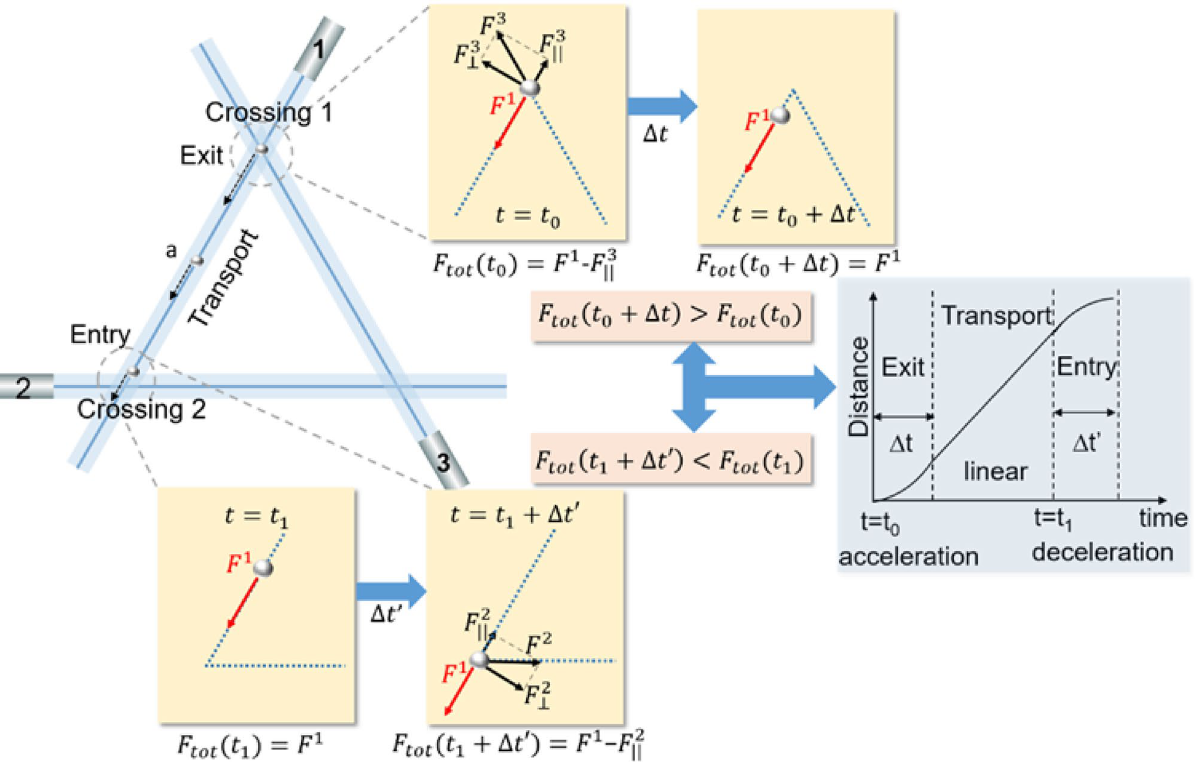
Figure 8. A qualitative explanation of three distinctive motions along a side of the optical triangle, ‘a’. The polystyrene bead moves from ‘Crossing 1’ to ‘Crossing 2,’ showing three segments I-Exit, II-Transport, and III-